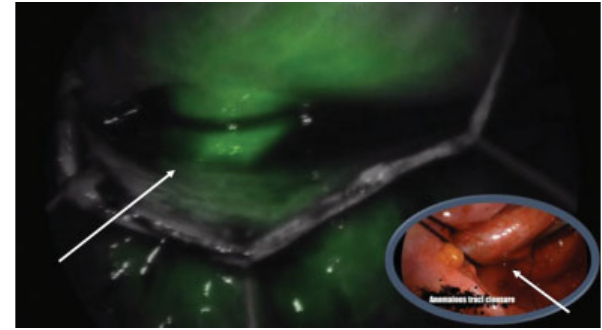
Fig. 1 Aortocoronary fi stula ligation. The image shows vascular permeability of the fi stula, clearly demonstrated with the uptake of indocyanine green through it.